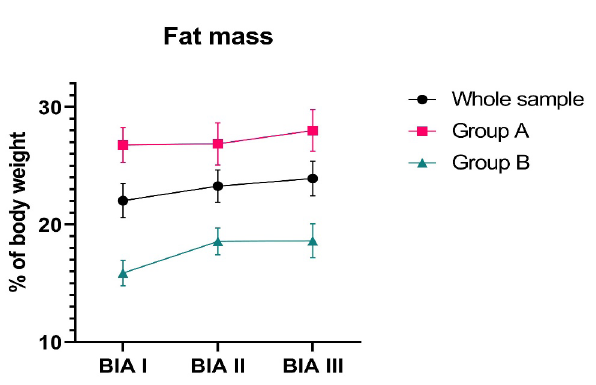
Fig. 1. Average weight change during the measurement. Data and error bars represent the mean ± SEM.